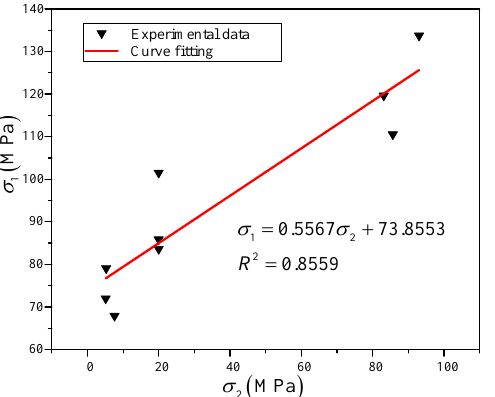
Figure 5. Fitting curve of strengthening effect of the IPS parameter in different experimental schemes.